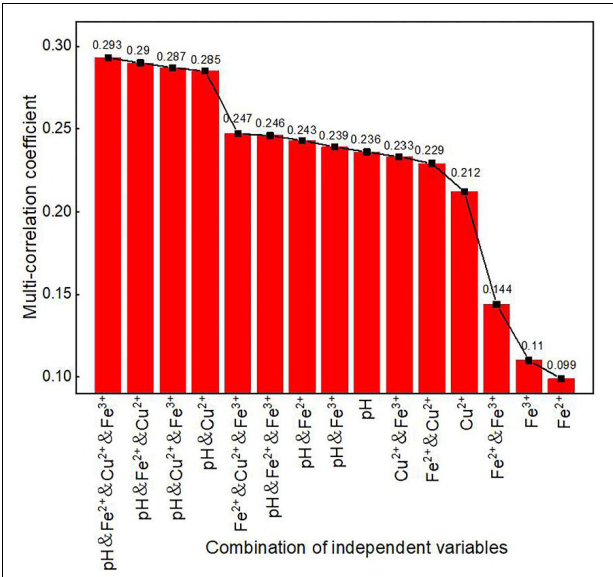
FIGURE 7 | Conjoint effect of temperature and pH on dissolved oxygen concentration.